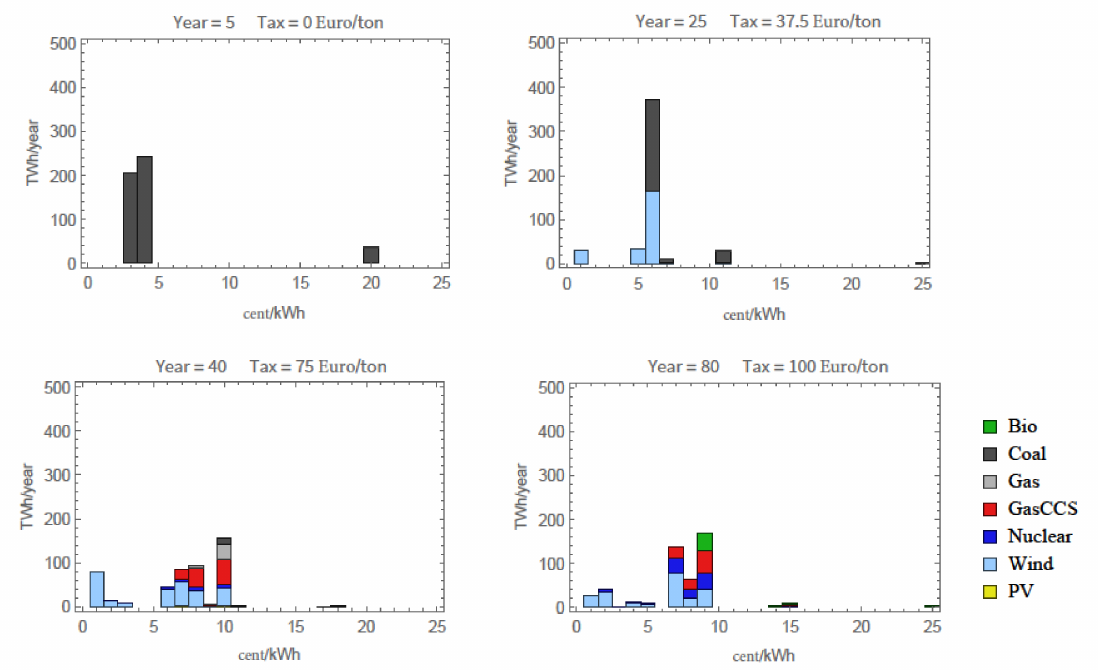
Figure 7. Power output at different price levels for four years (years 5, 25, 40, and 80) in the homogeneous case. Each column represents all production sold at prices in an interval [ p –1, p ] EUR cent/kWh, for integer values of p . The 25 EUR cent level also collects all production from higher prices. Each column shows produced amounts in merit order from bottom to